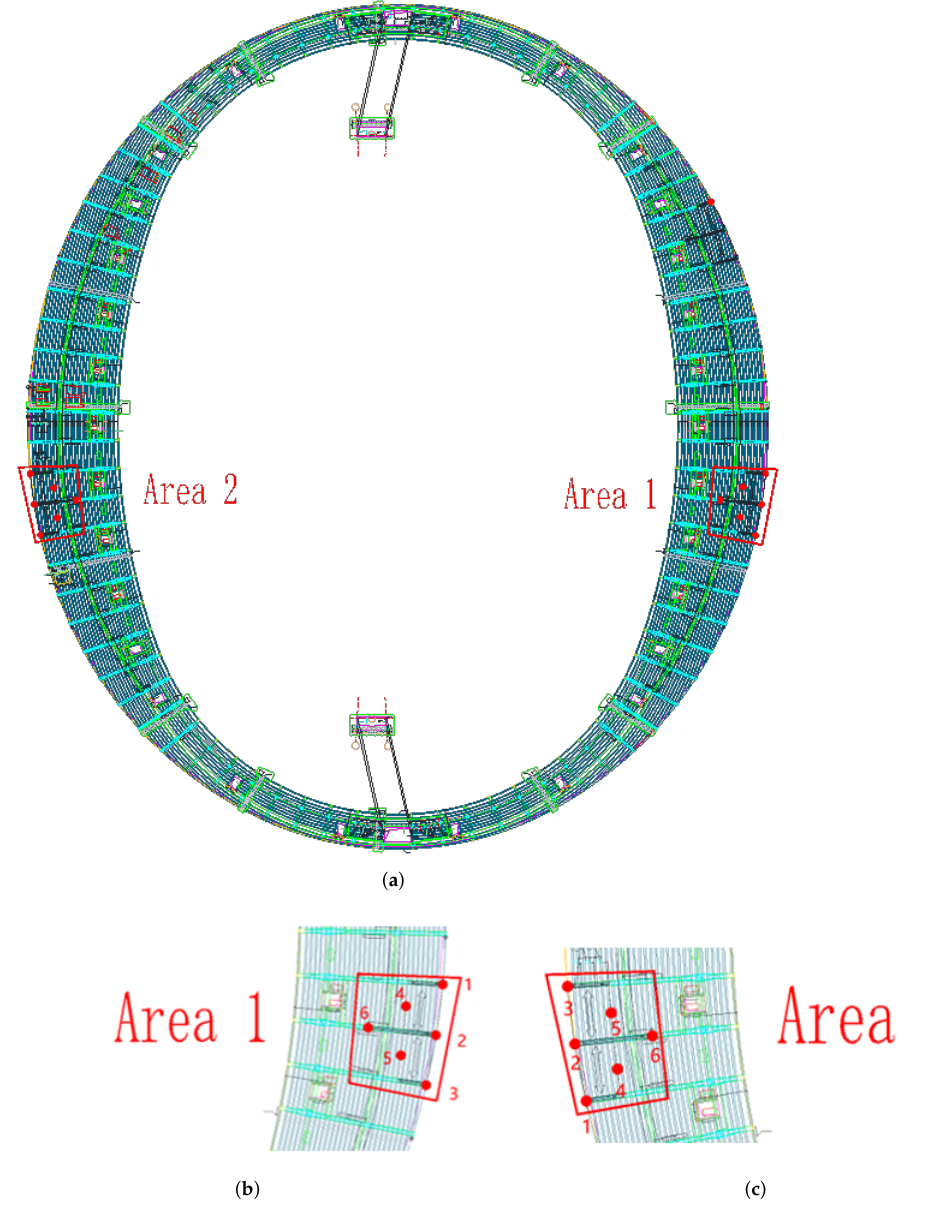
Figure 3. Distribution map of measuring points. ( a ) Area of crowd load response test; ( b ) Area 1; ( c ) Area